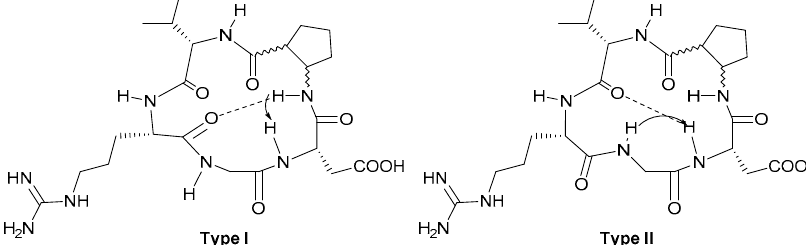
Figure 3. Preferred intramolecular H-bond / β -turn patterns proposed for peptidomimetics 8 and 9 based on spectroscopic data. The arrows indicate significant NOE contacts. Type I H-bonding pattern, Gly-Asp β -turn motif. Type II H-bonding pattern, Arg-Gly β -turn motif (the pattern definition is consistent with that previously reported for other cyclic RGD pentapeptide mimics) [28].